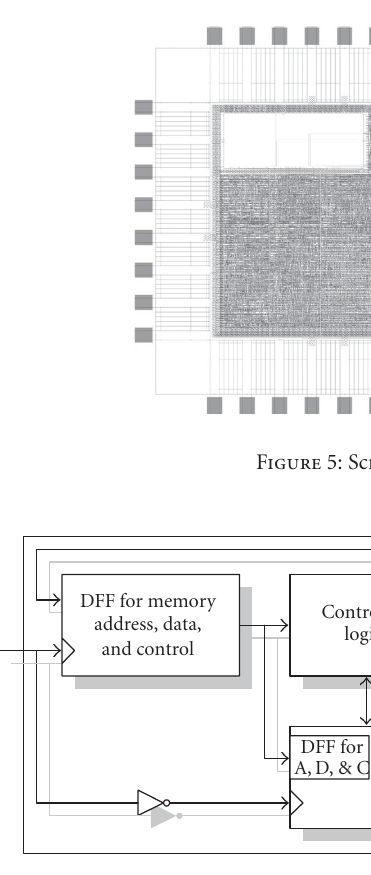
Figure 6: Two-phase clock controlling memory latches.